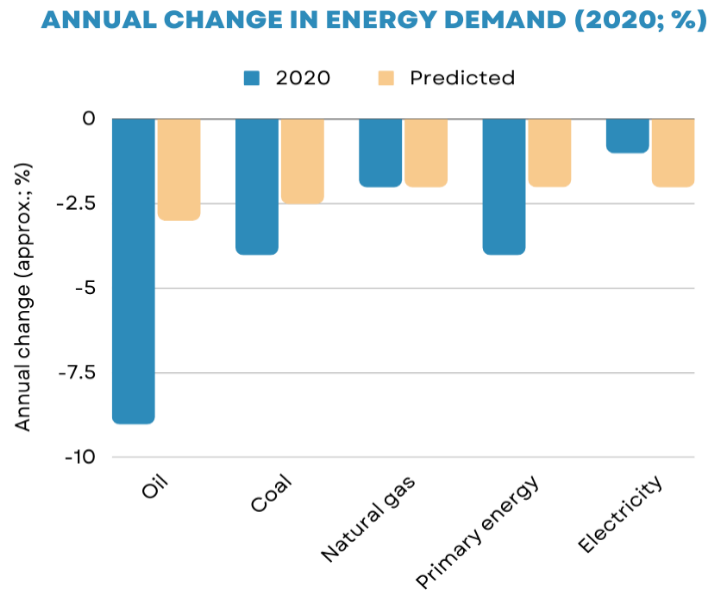
Figure 1. Predicted vs. actual annual change in energy demand (2020; %).